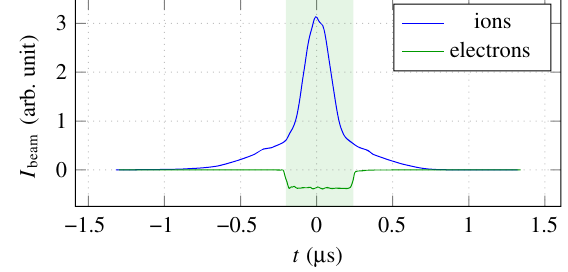
FIG. 8. Example of a frame reduced to a single bunch after corrections and averaging. The electron time axis is shifted to compensate for the time of flight between the BPMs. Parameters as in Fig. 7. Note that the visible irregularities in the ion bunch shape are not random and appear in all bunches within the frame.